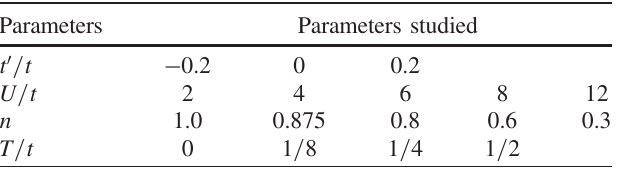
TABLE I. Parameters studied for the Hubbard model. Here, t denotes the nearest-neighbor hopping, t 0 the next-nearest-neigh- bor hopping, U the interaction strength, n the density, and T the